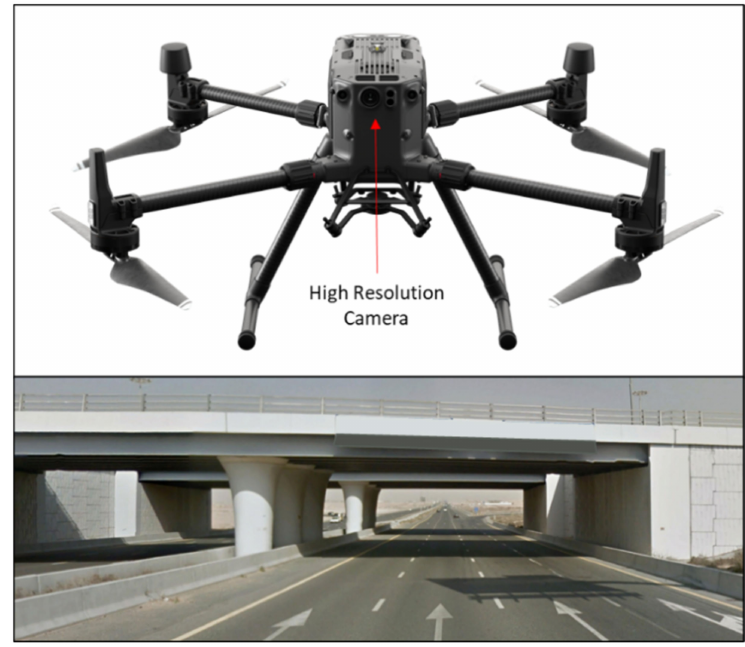
Figure 6. VI-UAV equipment and a sample of acquired